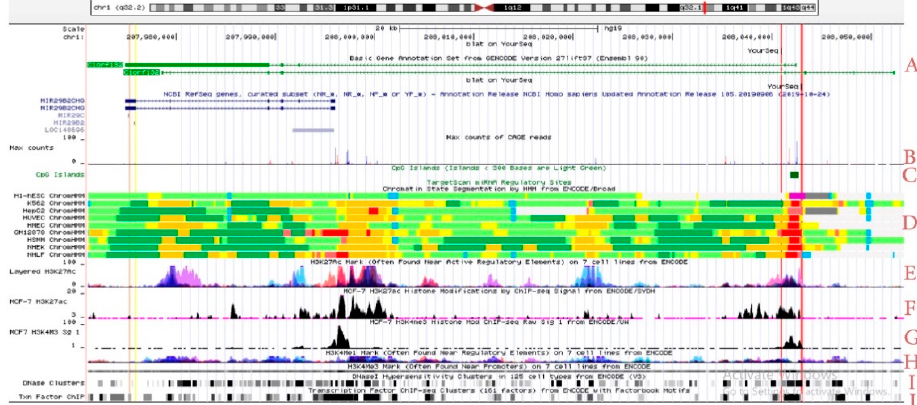
Figure 2. The genomic features of miR29b2c precursor. To make it easier to follow, the location of miR-29b2 and miR-29c are highlighted with yellow and purple color bands, respectively, and the potential distal transcription start sites of MIR29B2CHG with red color bands. As it is evident in the figure, there are several spliced variants for the miR29b2c precursor. In addition to the miR29b2c precursor (short variants), there are also longer variants of C1orf132 ( A ). Other bioinformatics features (UCSC Genome Browser hg19) support the existence of other start sites for C1orf132 transcription, including: Max counts of CAGE reads belonging to FANTOM5 summary ( B ), CpG island ( C ), active promoter-predicted elements according to Broad ChromHMM ( D ), active or potentially active regulatory elements of layered and MCF7 cells H3K27ac mark ( E , F ), active or potentially active promoter and enhancer regions marks by H3K4me3 and H3K4me1, respectively ( G , H ), DNase cluster ( I ), and transcription factor ChIP ( J ).